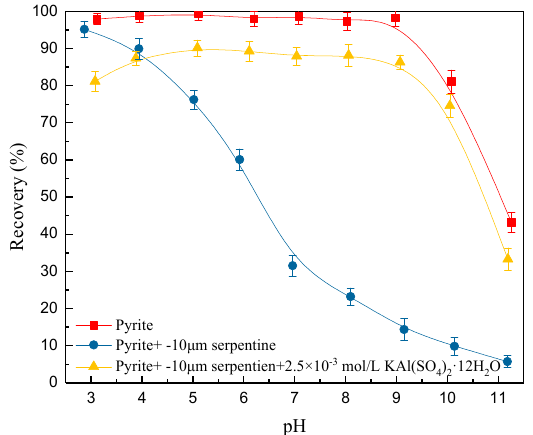
Figure 4. Flotation recovery of pyrite as a function of pulp pH ([PBX] = 3.75 × 10 − 5 mol/L, [MIBC] = 2 × 10 − 4 mol/L, [KAl(SO 4 ) 2 ·12H 2 O] = 2.5 × 10 − 3 mol/L).